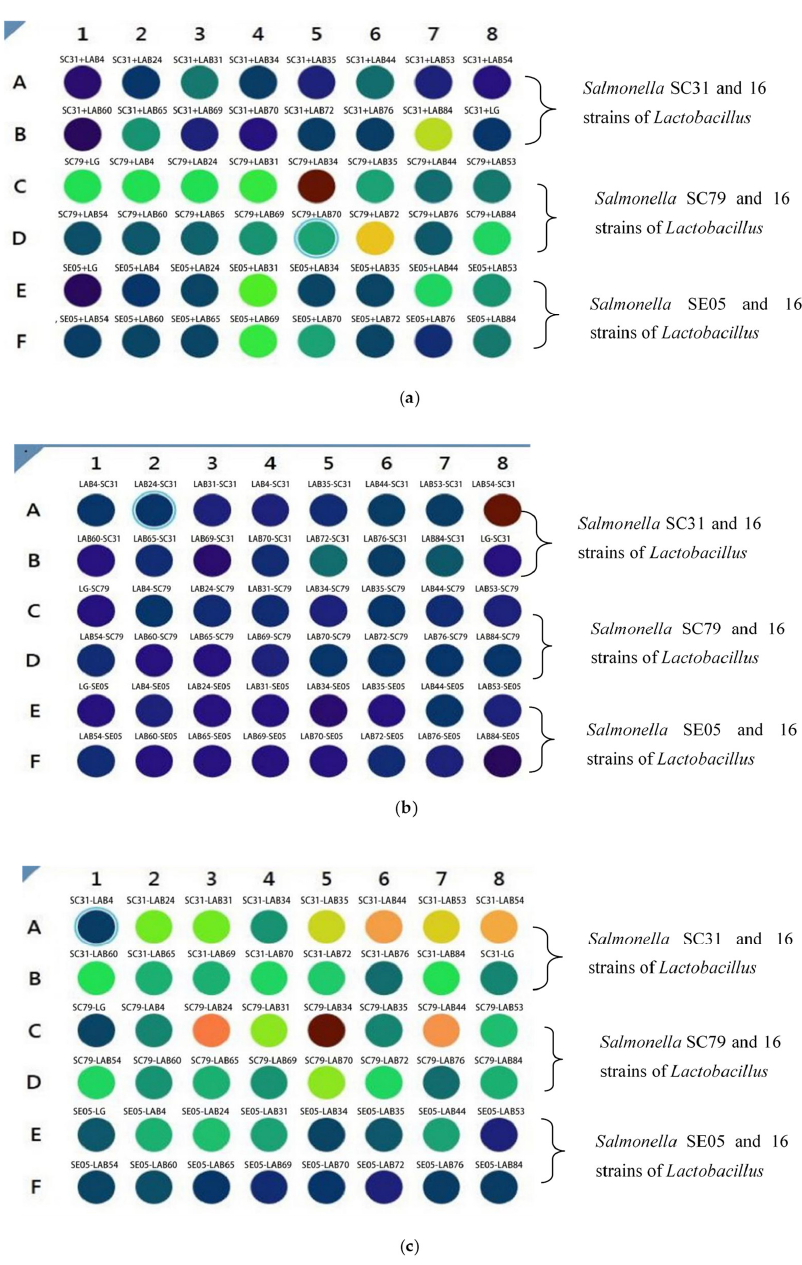
Figure 4. ( a ) Competitive adhesion test of Caco-2 cells incubated with Lactobacillus and Salmonella. In Figure 4a, The target Salmonella are SC31, SC85, and SE05. In this experiment, Lactobacillus and Salmonella were added at the same time and incubated for 1 h, then the fluorescence intensity was measured. The stronger the fluorescence intensity was, the more red the color was. It showed that the number of Salmonella incubated on Caco-2 cells was more, while the fluorescence intensity was weak, the color was blue, indicating that the number of Salmonella incubated on Caco-2 cells was small. ( b ) Rejection and adhesion test of Caco-2 cells incubated by lactic acid bacteria first and then by Salmonella. In Figure 4b, the Lactobacillus isolated strains were added for incubation for 1 h,